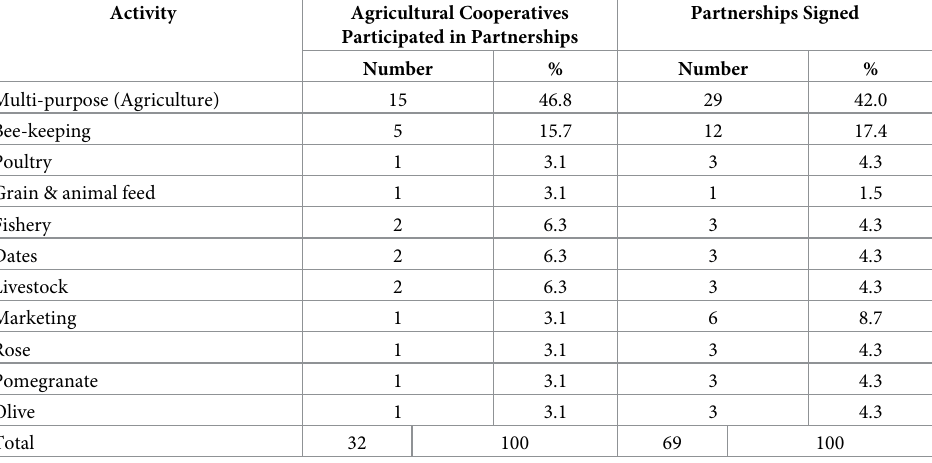
Table 3. Distribution of partnerships and agricultural cooperatives according to the main activities of agricultural